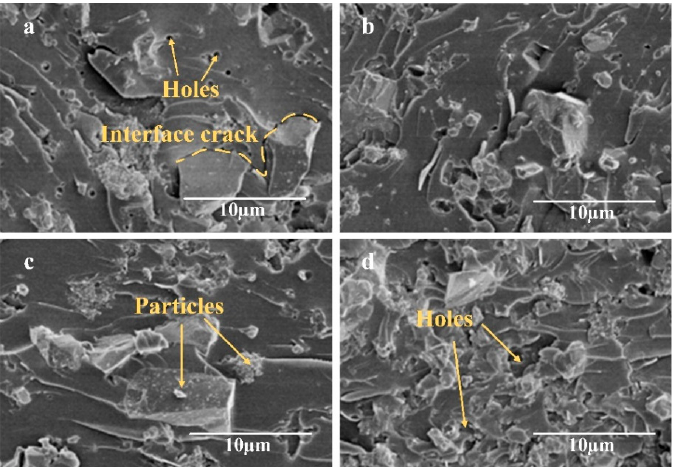
Figure 2. Micro-morphology of ZrB 2 –SiC-modified phenolic composite: ( a ) Unmodified ZrB2–SiC-modified phenolic composite, ( b ) C1 sample, ( c ) C2 sample, and ( d ) C3 sample.